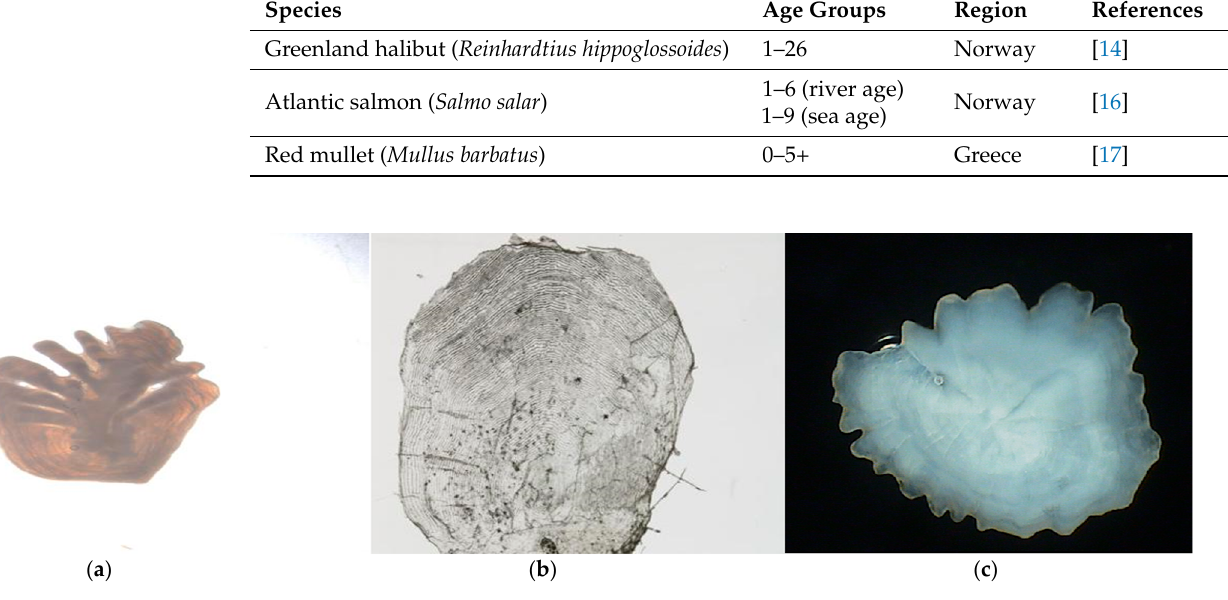
Figure 2. Fish species that are currently processed through the DeepOtolith platform: ( a ) Greenland halibut ( Reinhardtius hippoglossoides ) otolith, ( b ) Atlantic salmon ( Salmo salar ) scale, and ( c ) red mullet ( Mullus barbatus ) otolith. Table 1. Fish species that are currently available on the DeepOtolith platform. Species